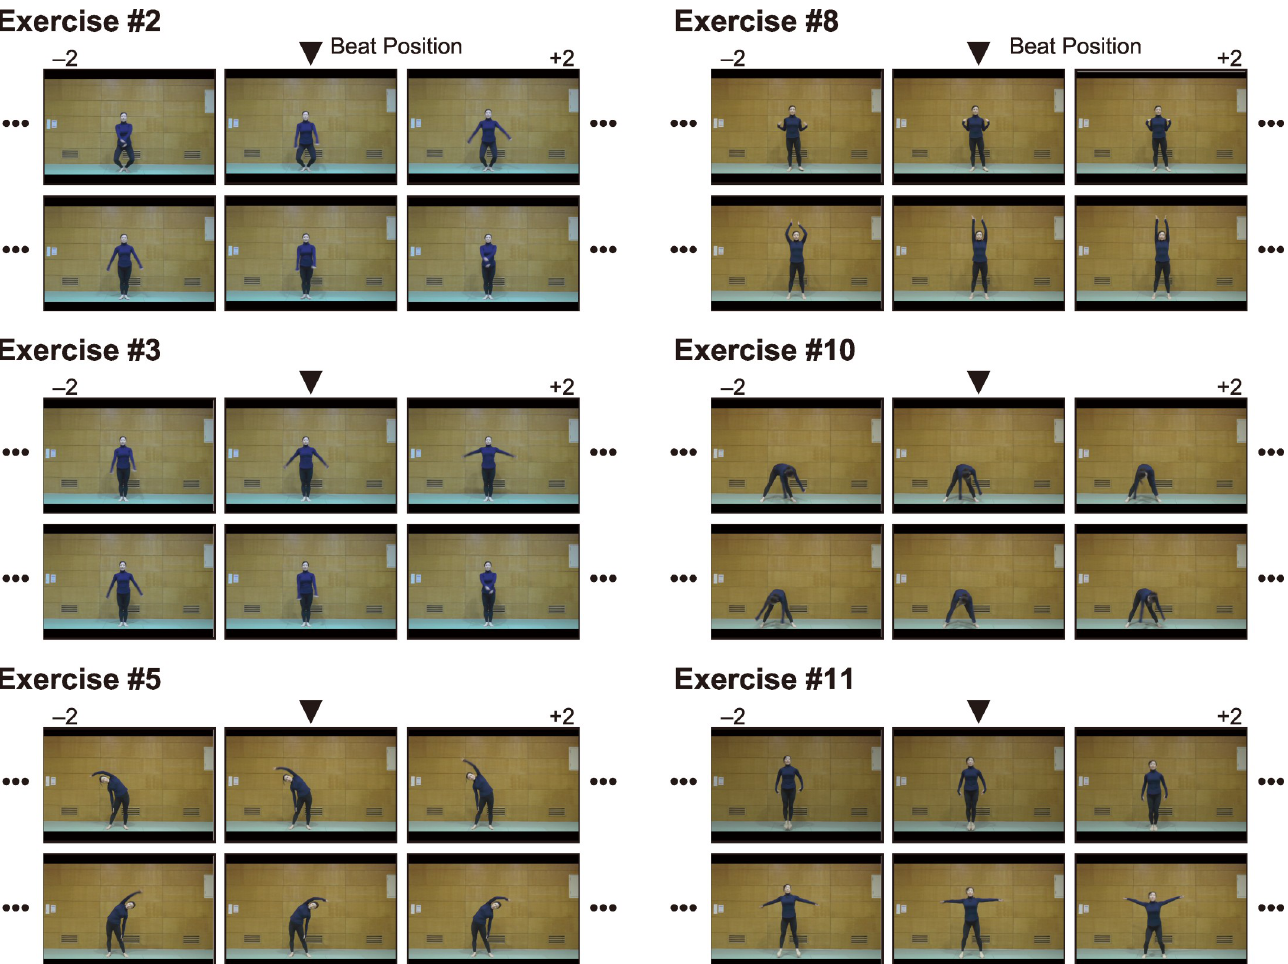
Fig 4. Movement features synchronized with music beats. This figure shows the video frames at the music beats when the audiovisual temporal shift was set to the average PSS value. In every panel, the central snapshot represents the frame at the music beat, and the intervals between adjacent snapshots are 2 frames (i.e., 66